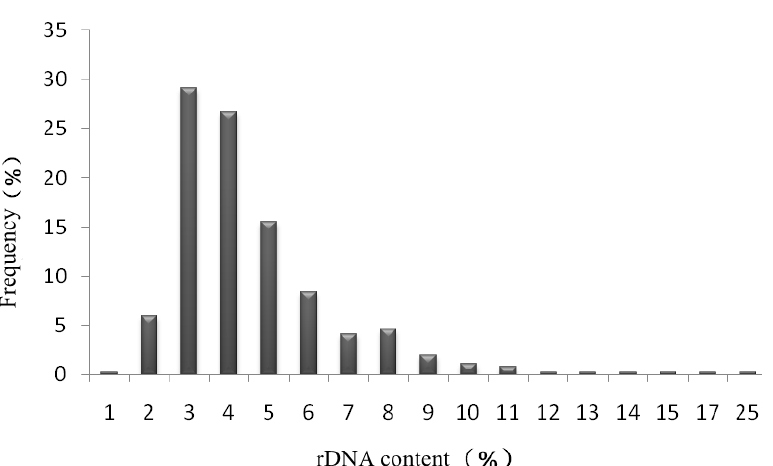
Figure 2. Assessment results of residual rDNA content in different transcriptome data. Note: the horizontal axis represents the rDNA content of the transcriptome data, and the vertical axis represents the proportion of different contents.